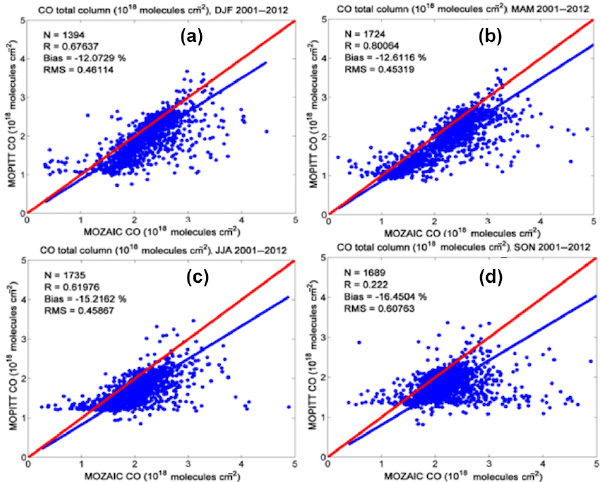
Figure 13. Global MOPITT CO column retrievals versus trans- formed trajectory-mapped MOZAIC-IAGOS CO climatology col- umn for four seasons. The bias is calculated as the difference for each grid cell, [2(MOPITT-Clim) / (Clim + MOPITT)], averaged over all grid cells. The blue line is the line of best fit, the red line is the 1 : 1 line, and the correlation coefficient ( R) , total number of data points ( N) , and root mean square error (RMS) are indicated.